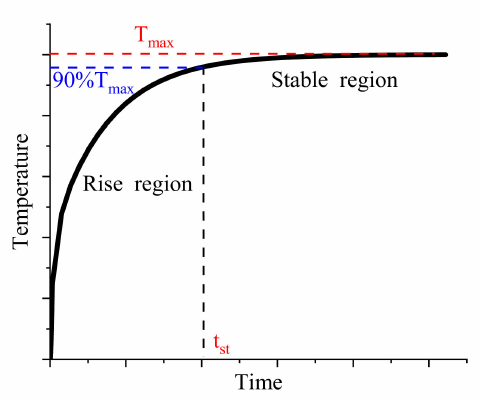
Figure 5. Schematic diagram of transient evaluation